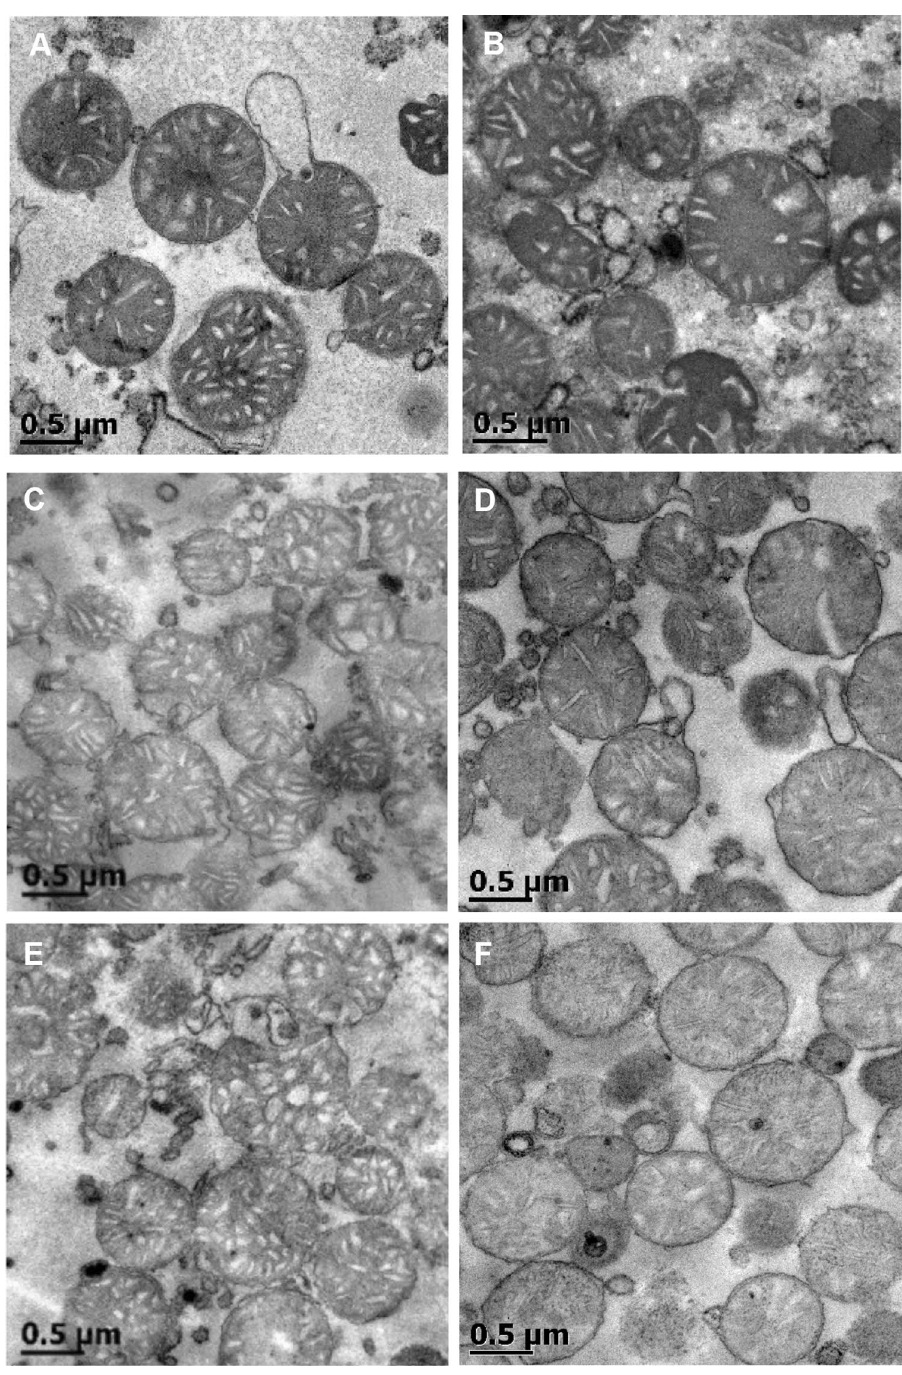
Figure 3. Electron microscopy of hepatocytes mitochondria from mice after cholesterol-rich diet and rosuvastatin. Liver mitochondria from male mice that were treated with ( A ) HD + Ro 5 mg/kg/day 11 days; ( B